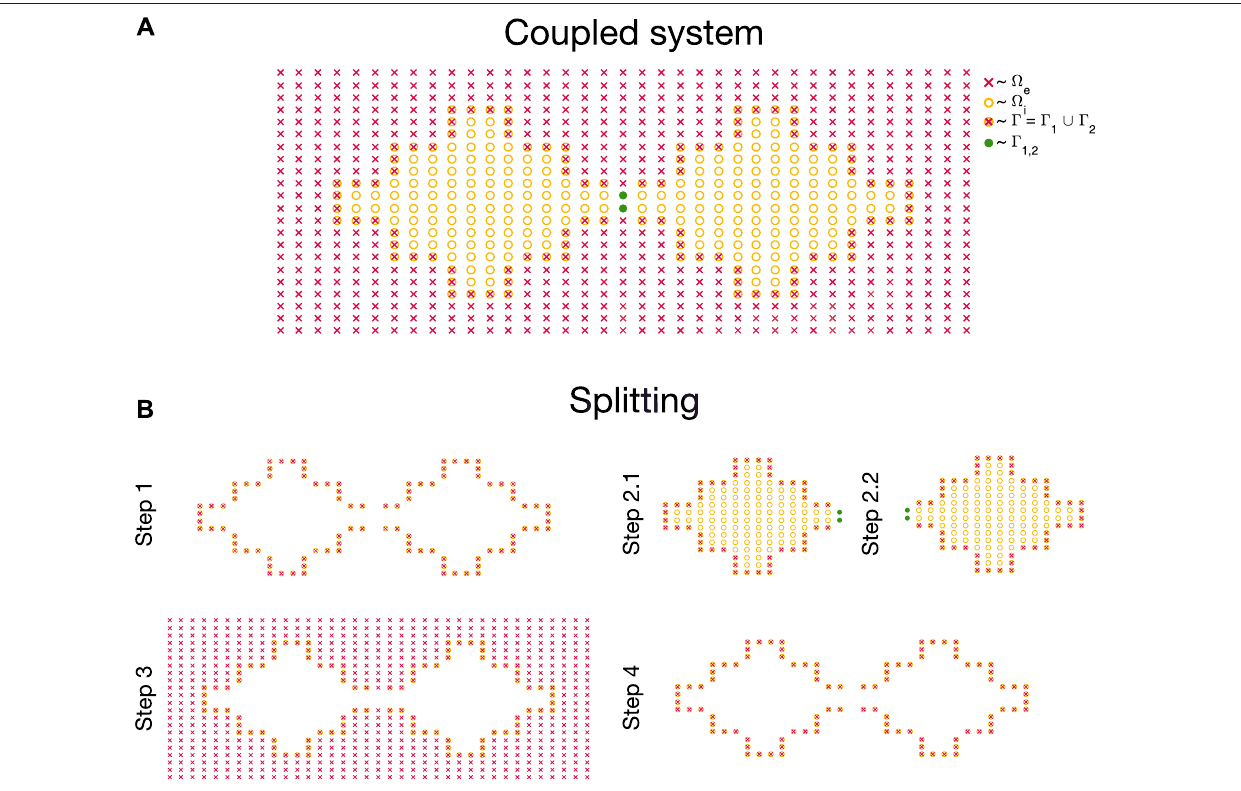
FIGURE 7 | Illustration of the computational mesh used in the coupled (A) and split (B) versions of the fi nite difference discretization of the EMI model for two connected cells. The mesh consists of four types of computational nodes; nodes located in the extracellular domain, marked by × , nodes located in the intracellular domain, marked by ° , nodes located at the membrane, marked by ⊗ , and nodes located at the intercalated disc, marked by (cid:129)